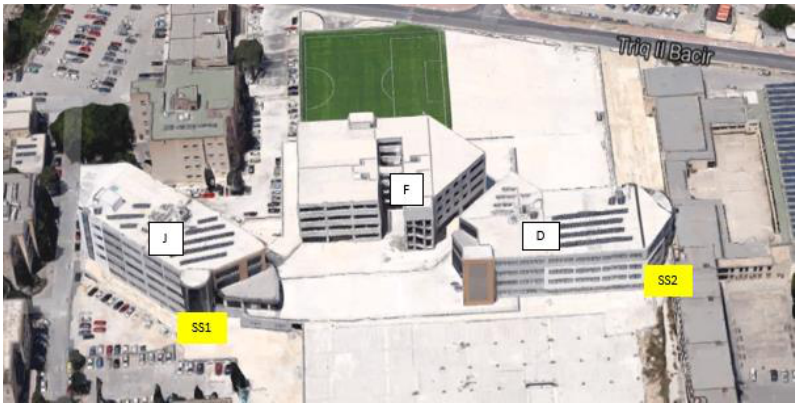
Figure 1. Aerial view of MCAST buildings as part of the micro-grid. Table 1. Description of layout